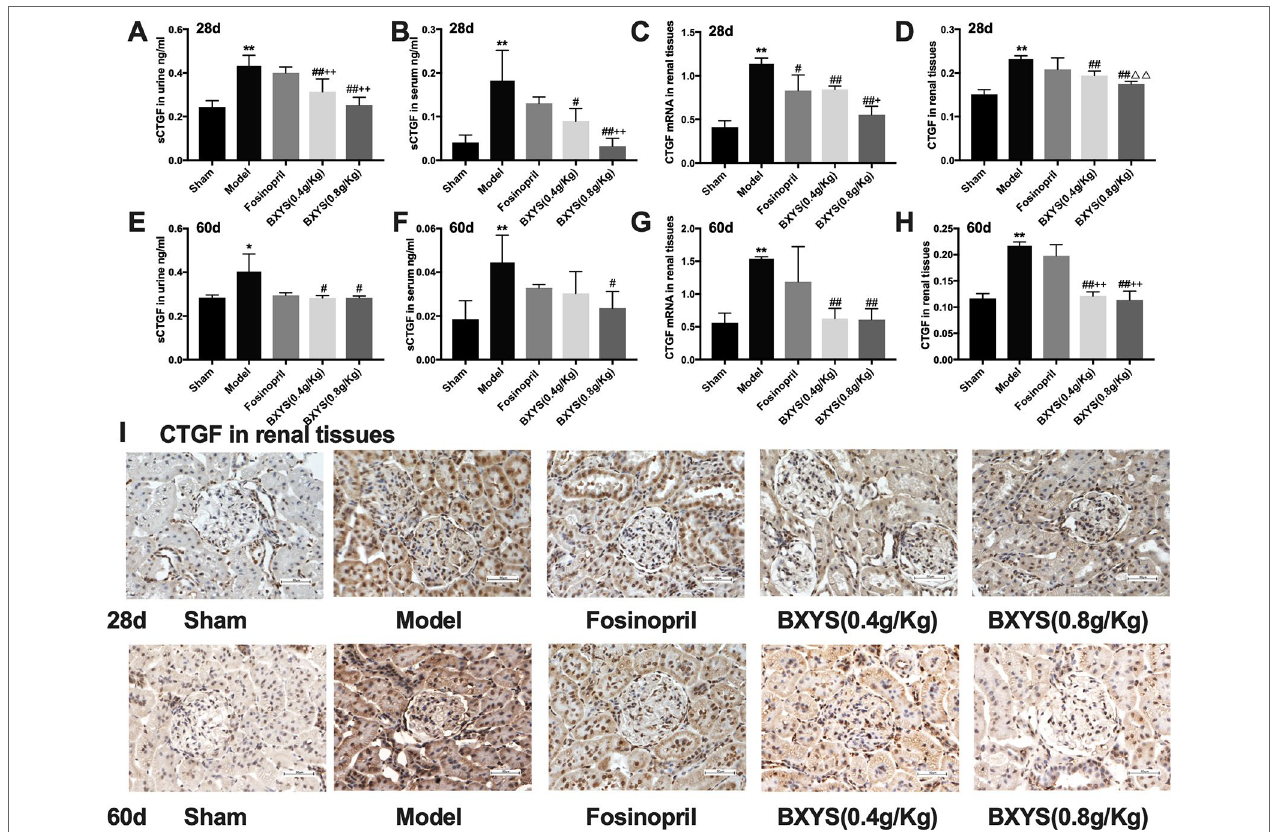
FIGURE 4 | sCTGF concentration in serum, urine and CTGF mRNA, CTGF expression in renal tissues after 28 days and 60 days of drug administration. Sham, sham group; Model, model group; Fosinopril, fosinopril group; BXYS (0.4 g/kg), Buxin Yishen 0.4 g/kg treated group; BXYS (0.8 g/kg), Buxin Yishen 0.8g/kg treated group. *P < 0.05, **P < 0.01 vs. sham group. # P < 0.05, ## P < 0.01 vs. model group. + P < 0.05, ++ P < 0.01 vs. fosinopril group. △△ P< 0.01 vs. BXYS (0.4 g/Kg) group. (A) Soluble connective tissue growth factor (sCTGF) levels in urine after 28 days. (B) sCTGF levels in serum after 28 days. (C) CTGF mRNA expression in renal tissues after 28 days. (D) CTGF expression in renal tissues after 28 days. (E) sCTGF levels in urine after 60 days. (F) sCTGF levels in serum after 60 days. (G) CTGF mRNA expression in renal tissues after 60 days. (H) CTGF expression in renal tissues after 60 days. (I) CTGF expression in renal tissues (×400 magnification). Upper panel shows analysis after 28 days of administration and the lower panel shows analysis after 60 days of